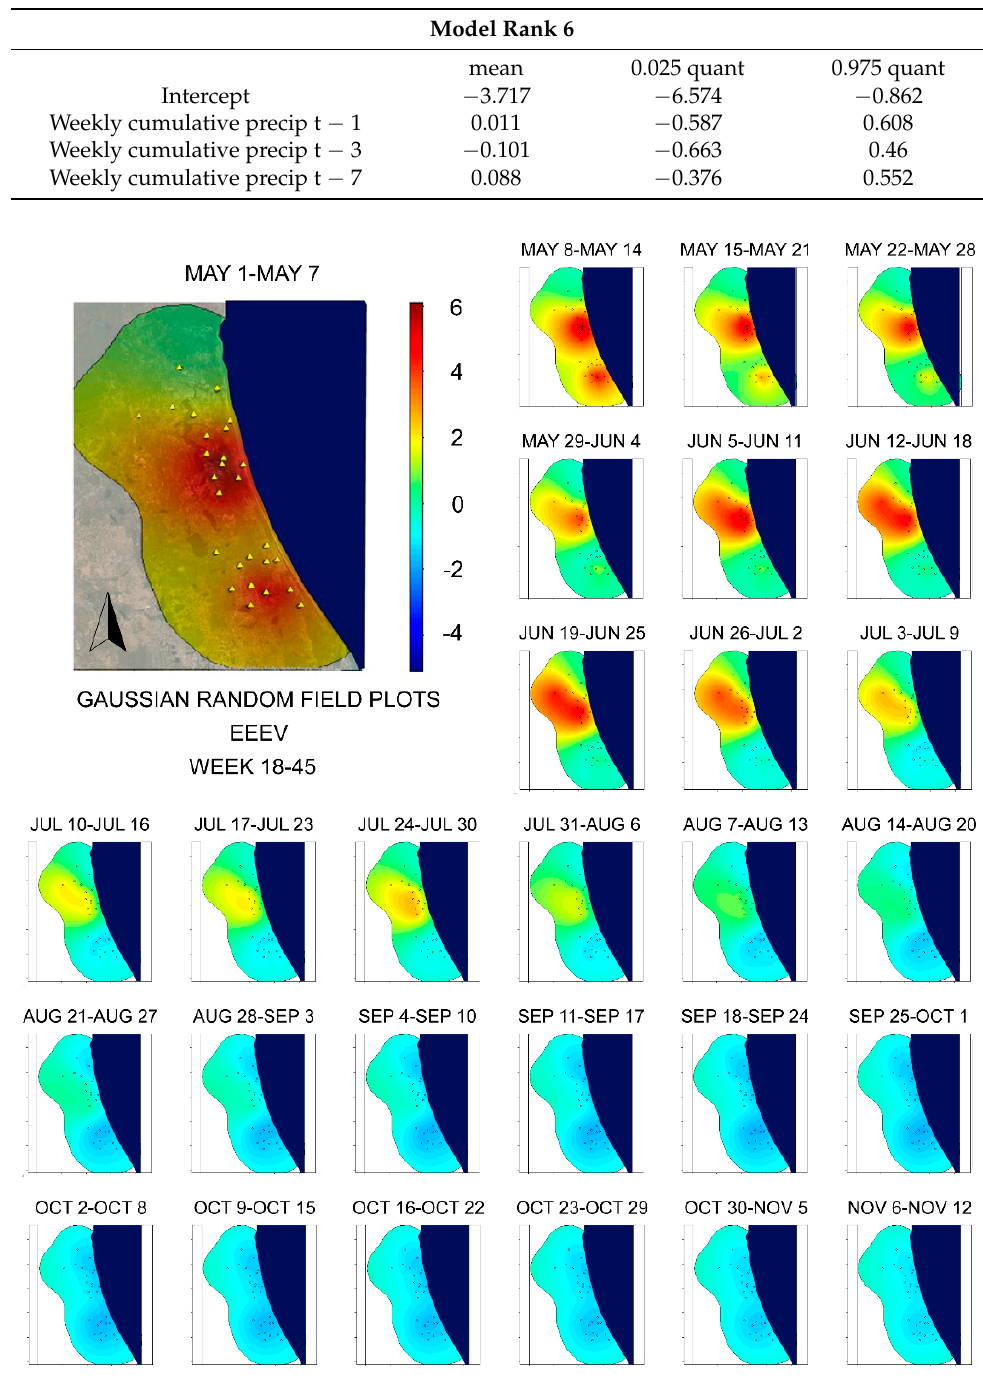
Figure 5. Weekly plots of spatiotemporal Gaussian Markov random fields (GMRF) for week 18–45 2018 EEEV sentinel chicken seroconversion rates. A convex hull was generated to create the GMRFs, and the GMRFs were clipped to the coastline for visualization. The ESRI background imagery was used to map the first plot (1–7 May).